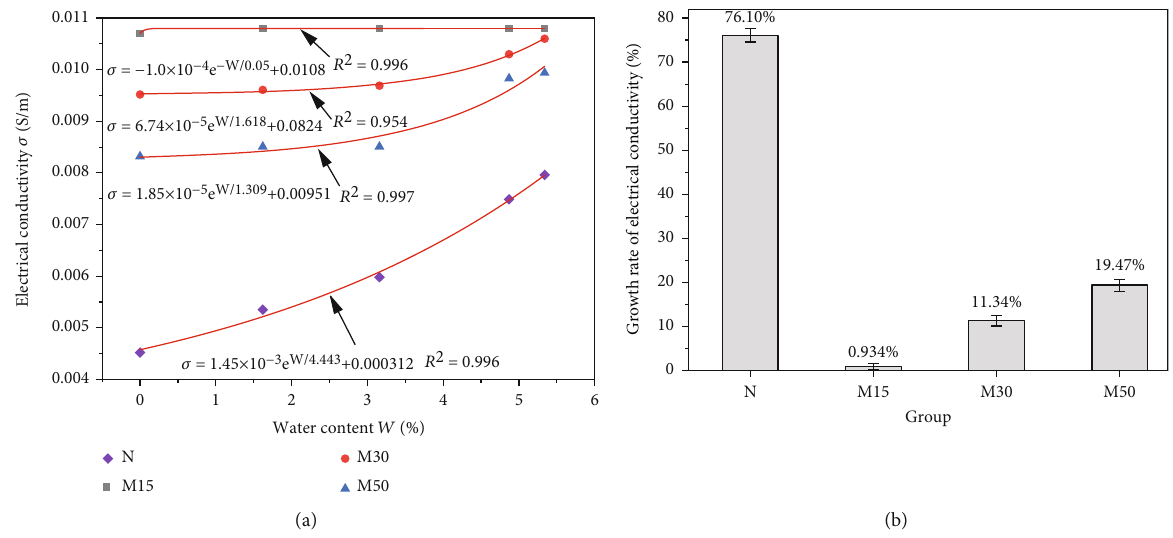
Figure 4: (a) Electrical conductivity of MWCNTs/CM under di ff erent water contents at 12 ° C. (b) The growth rate of electrical conductivity when the water content of the specimen is 5.34%. Table 6: Pore structure characteristic parameters of CM and